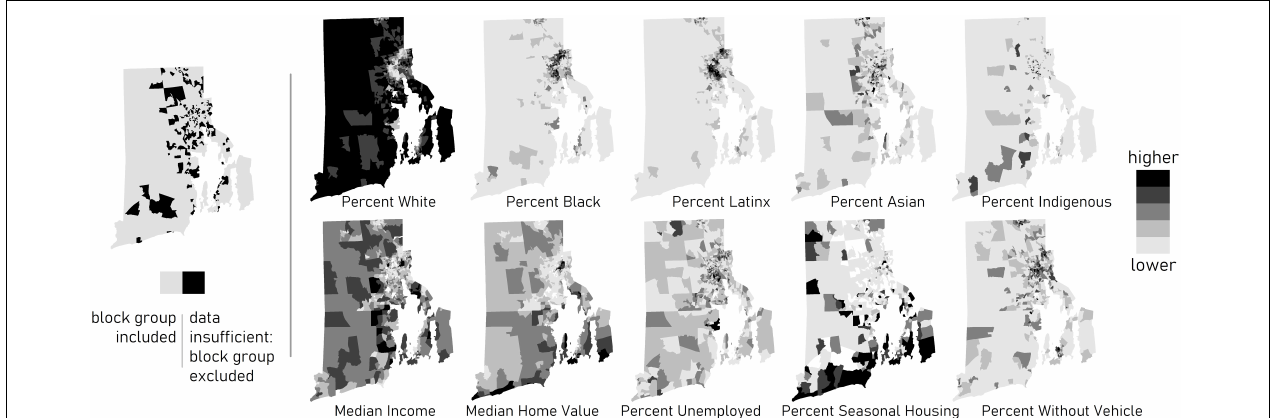
FIGURE 2 | On the left, 206 census block groups (in black) were excluded from the regression analyses due to insufficient data for some of the demographic variables. On the right, choropleth maps of demographic variables, symbolized using five-class natural breaks to optimize the uniformity of values in each class [U.S. Census American Community Survey (ACS) 5-Year Data Profiles, 2012–2016]. Darker shades indicate higher